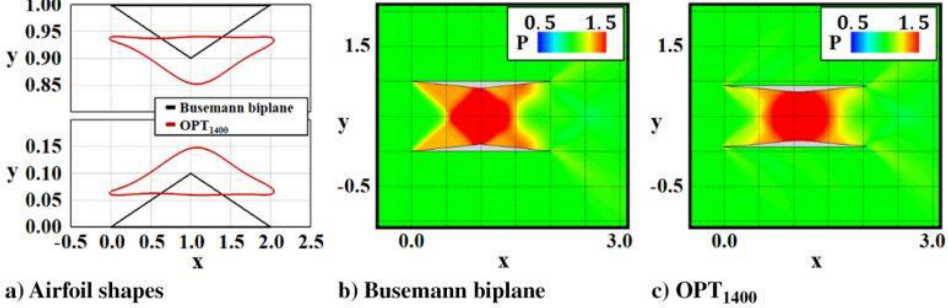
Figure 3. Comparison between the Busemann biplane and the final optimal airfoils [1].